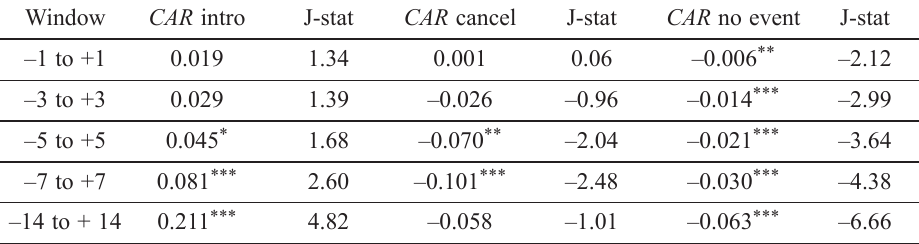
Table 4. Averaged CAR statistics for trademark introduction and cancellation with different event windows fi ltering by M&A announcements